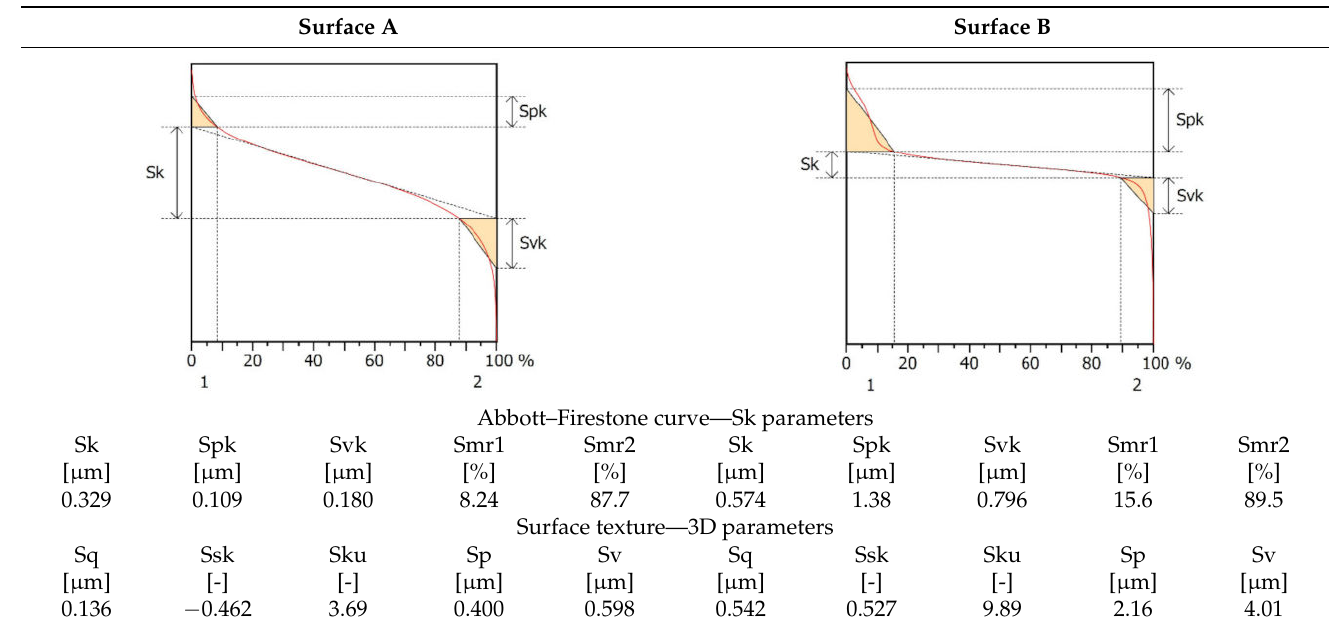
Table 5. Results of manufactured surface topography—Abbott–Firestone curve and parameters.